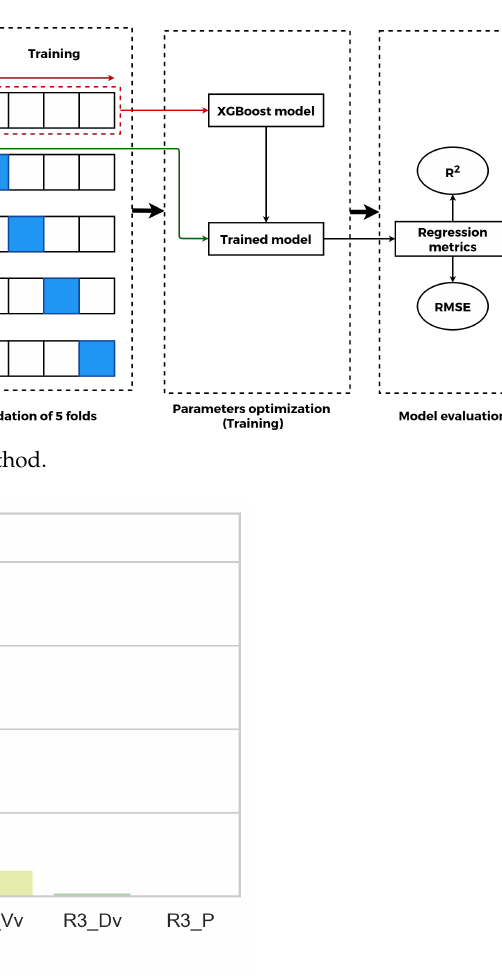
Figure 10. The features’ importance bar chart of meteorological